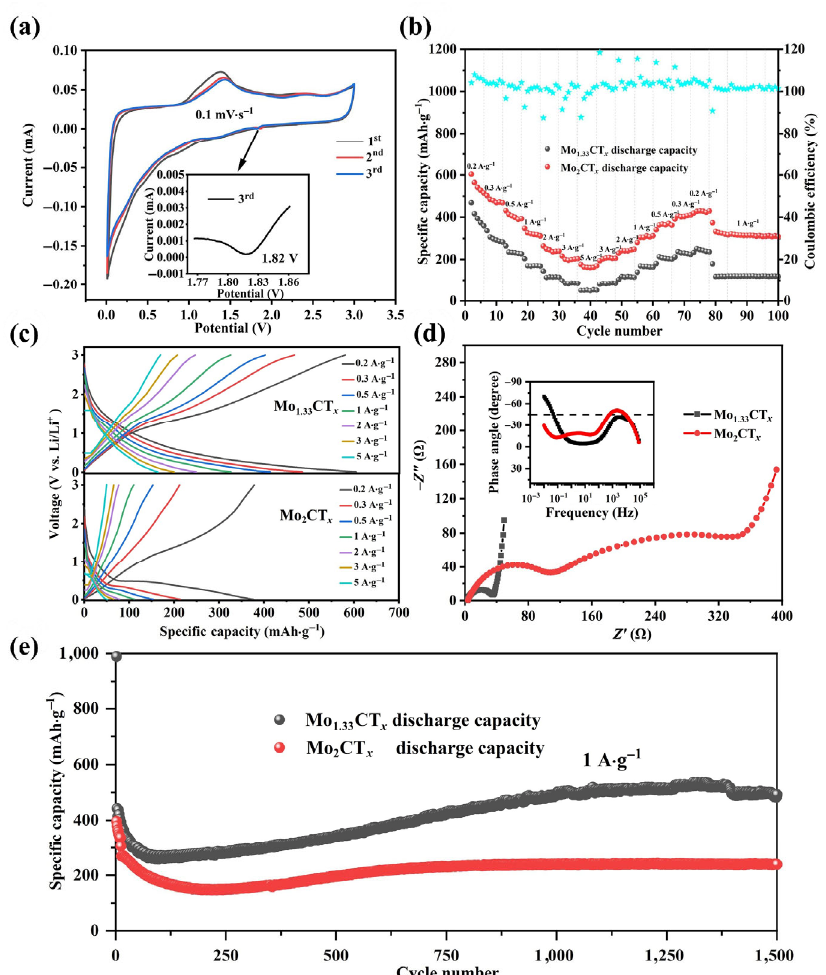
Figure 3 Electrochemical performance of Mo 1.33 CT x for lithium-ion battery. (a) Cyclic voltammetry measured of Mo 1.33 CT x at 1 mV·s −1 . Inset: partial enlargement of 1.76–1.88 V. (b) Rate performance of Mo 1.33 CT x and Mo 2 CT x electrodes from 0.2 to 5 A·g −1 . (c) The galvanostatic charge and discharge curves of Mo 1.33 CT x and Mo 2 CT x electrodes at different current densities. (d) The AC impedance spectroscopy of Mo 1.33 CT x and Mo 2 CT x electrodes after CV curves. Inset: Phase angle and frequency relationship diagram. (e) Cycling stability of Mo 1.33 CT x and Mo 2 CT x electrodes at 1 A·g −1